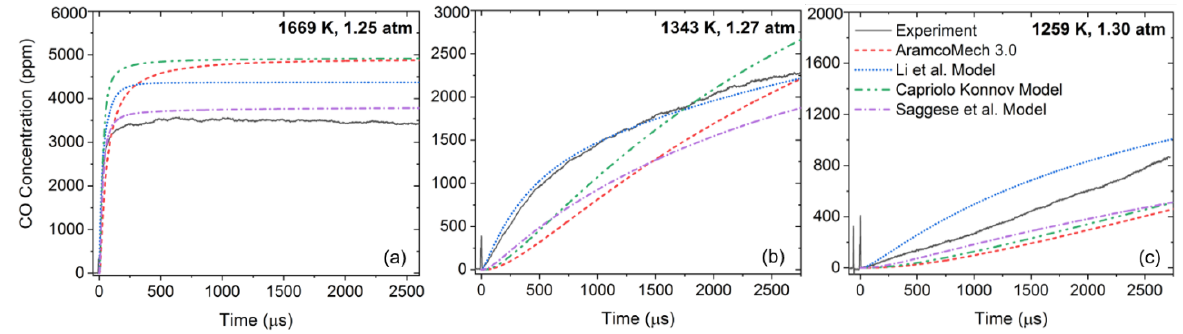
Figure 3. CO time-history results for ( a ) high-, ( b ) intermediate-, and ( c ) low-temperature cases near 1.3 atm in Mix 2 from Table 1. Predictions made by the four kinetics models are also shown.